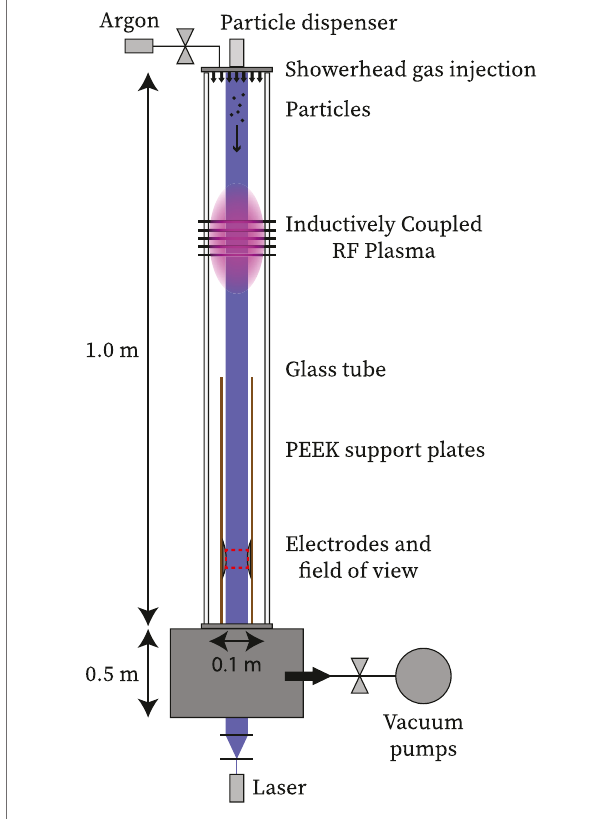
FIGURE1| Schematicsideviewoftheexperimentalsetup.Notethatthe vacuum vessel on the bottom of the setup in reality has a large and complex shape, which is simpli fi ed in this fi gure as a rectangle and is not depicted to scale. The red rectangle represents the fi eld of view of the high speed